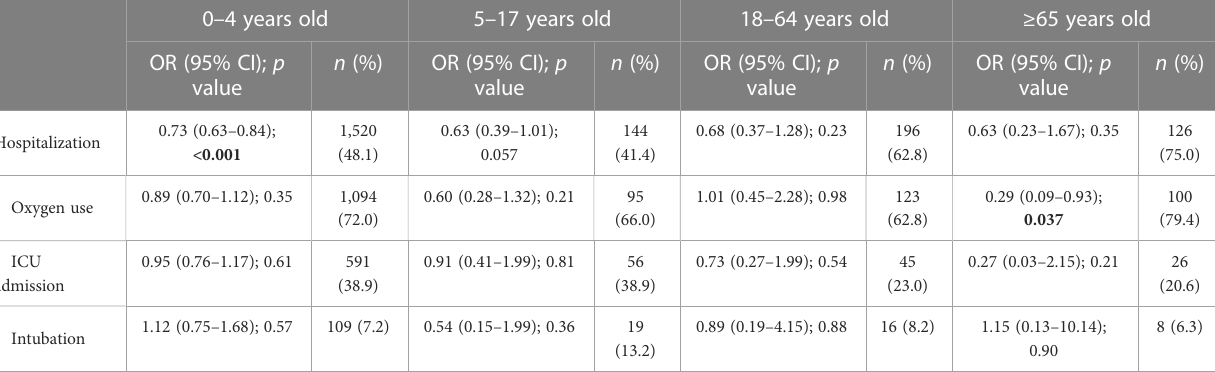
TABLE 2 Logistic regression models comparing the age group – speci fi c odds of hospitalization, and among those hospitalized, oxygen use, ICU admission, and intubation between individuals with RSV single detection (reference group) and those with co-detection.